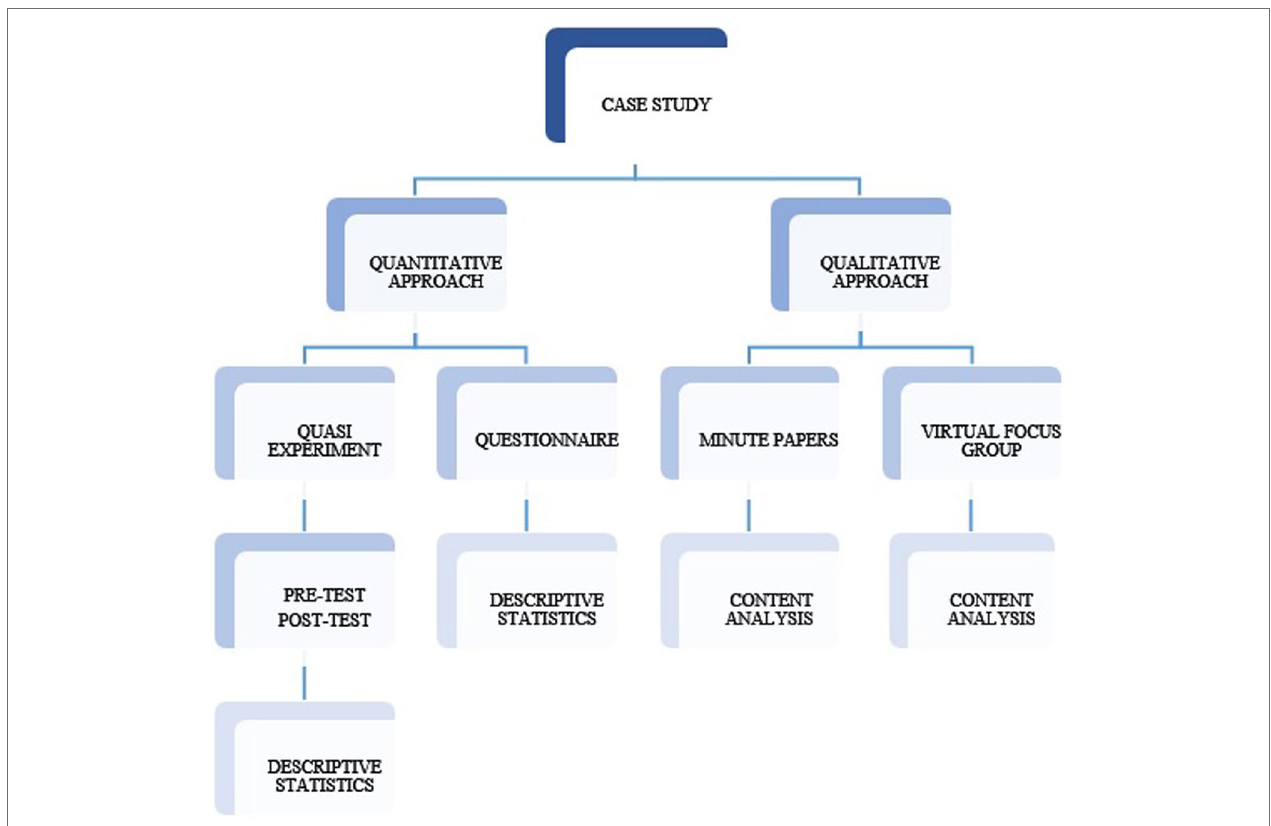
FIGURE 3 | Research design.